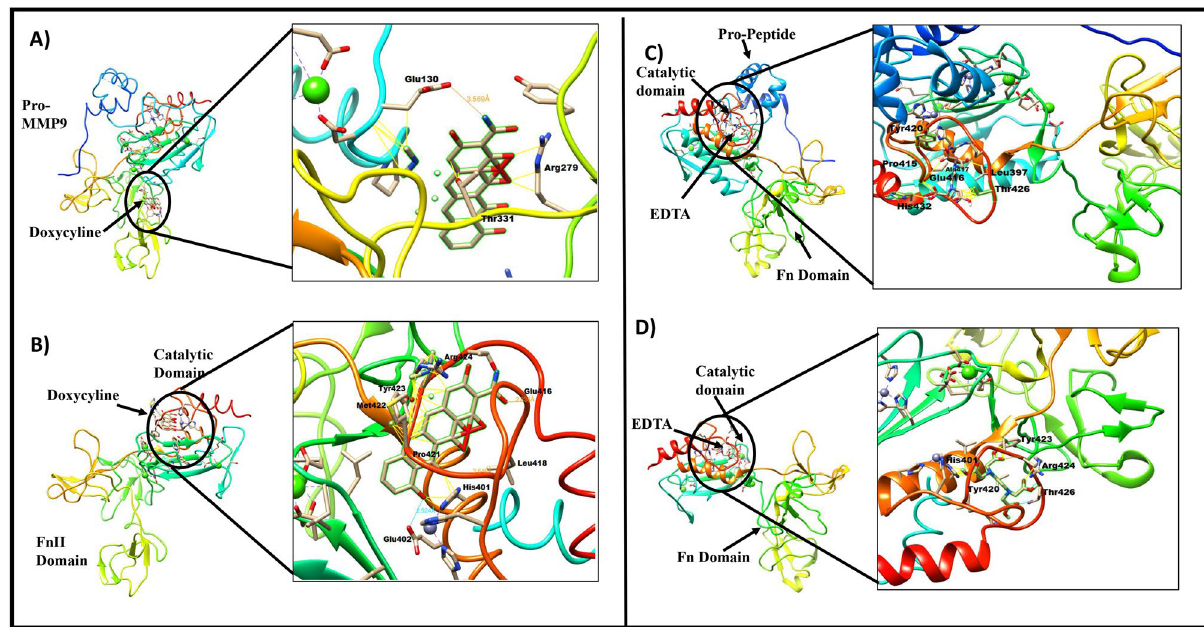
Figure 3. Predicted interactions of doxycycline with pro-MMP9 ( A ), and active MMP9 ( B ). Predicted interactions of EDTA with pro-MMP9 ( C ), and active MMP9 ( D ). The important amino acids involved in these interactions at the predicted sites are shown in bold black